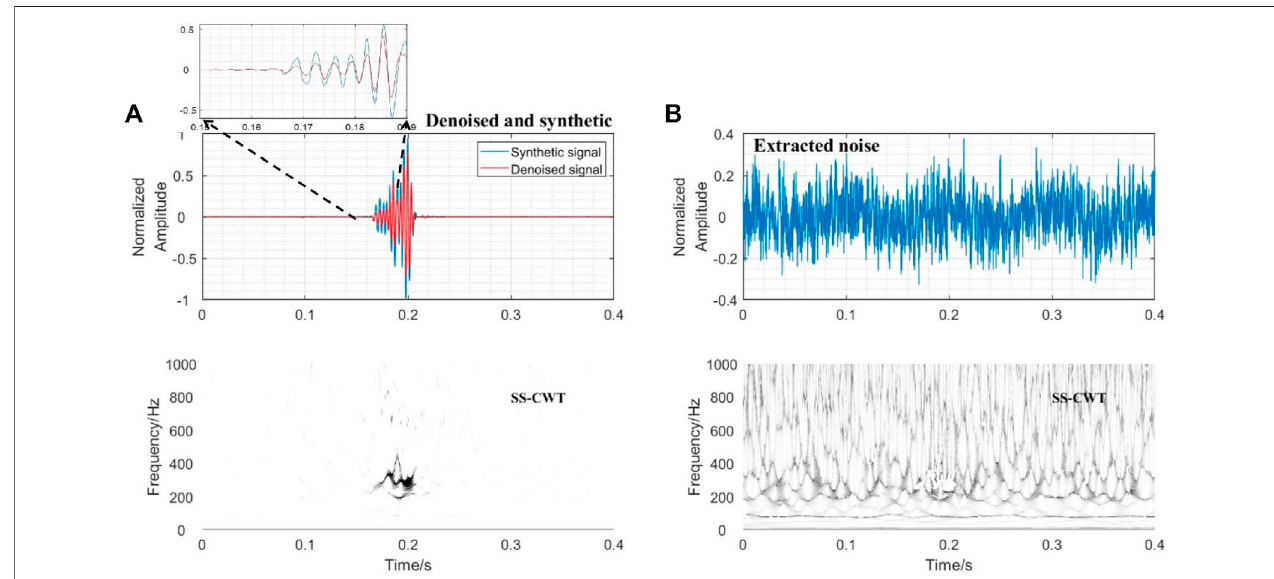
FIGURE 4 | (A) Denoised seismogram and its associated SS-CWT. (B) Extracted noise and its associated SS-CWT.